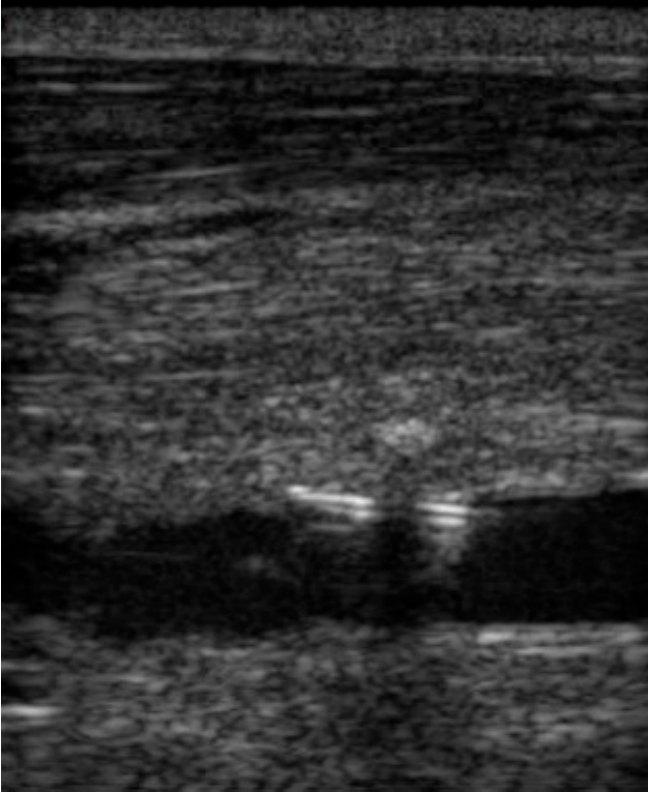
Figure 5. Longitudinal ultrasound image with the Angio-Seal device properly positioned for closure of the common carotid artery puncture.